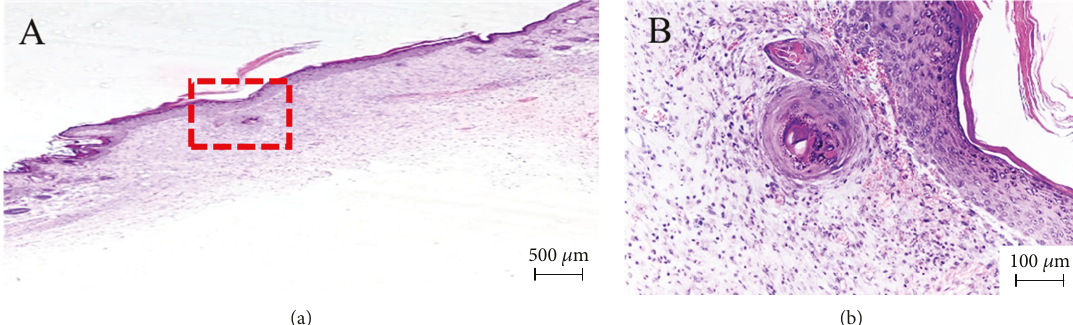
Figure 10: H&E staining (a, b) images of the full defected area of the skin treated with PCA60 captured at 4x magni fi cation and each enlarged part captured at 20x magni fi